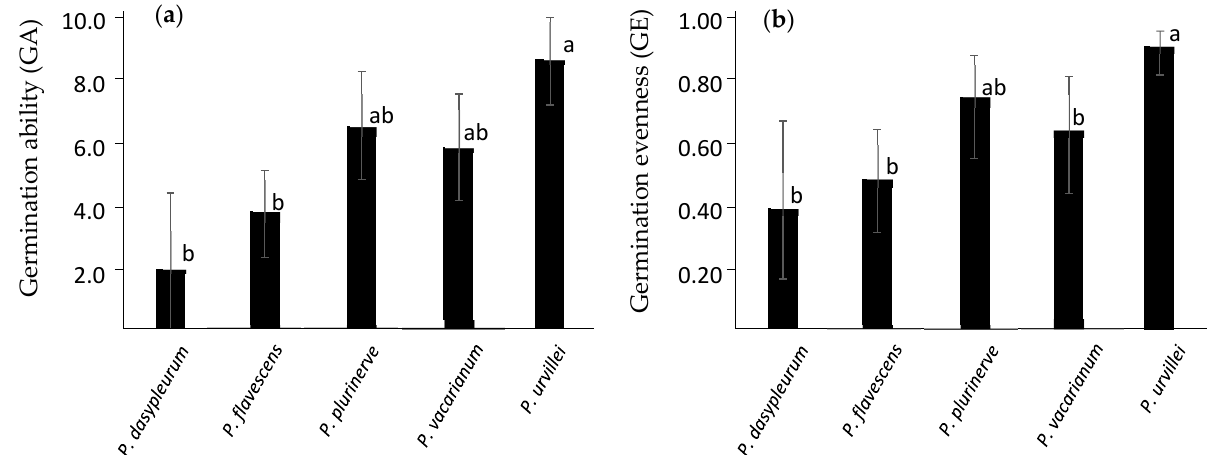
Figure 2. ( a ) Mean germination ability (GA) and ( b ) mean germination evenness (GE) for each species. These variables were generated to estimate both seed dormancy and germination niche breadth. GE data were logit transformed before analysis. Vertical lines indicate a 95% confidence interval. Different letters mean significant differences among species within each germination variable.